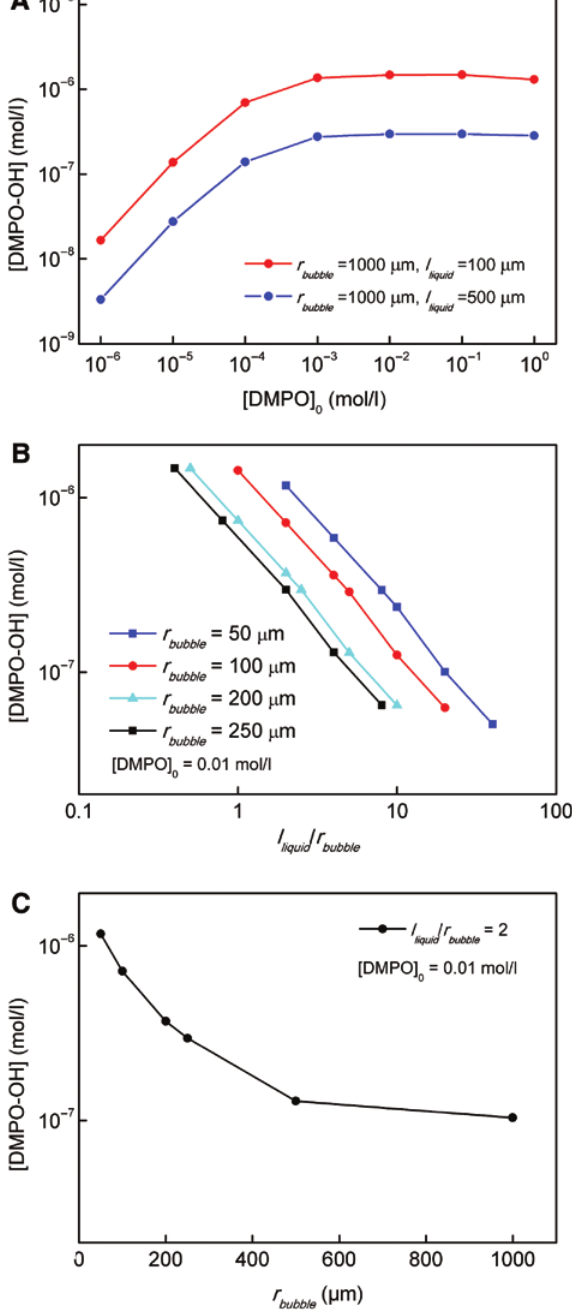
Figure 7: Model predictions of the final spin adduct concentration: (A) at different initial DMPO concentrations; (B) at different lliquid/ r ratios; (C) at different bubble bubble